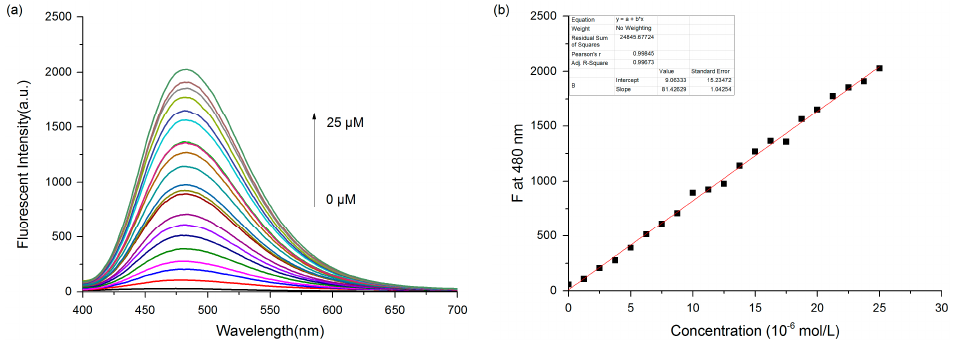
Figure 3. ( a ) Fluorescence spectra of probe 1 (5 µM) in the presence of various concentration of CN −